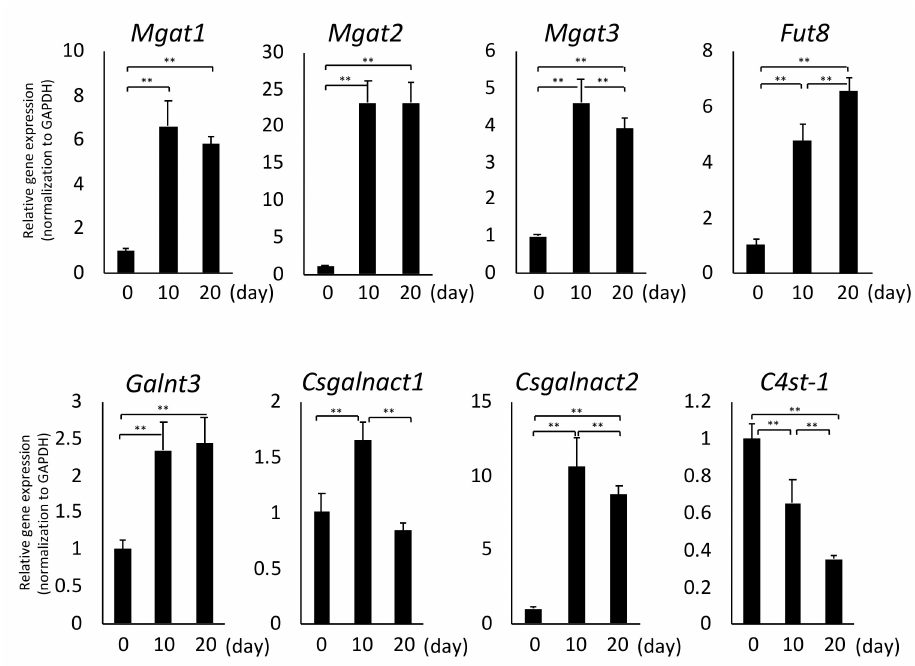
Figure 5. Gene expression levels of glycosyltransferases during hypertrophic di ff erentiation involved in glycan biosynthesis and processing. The mRNA expression levels on the indicated days as determined by quantitative RT-PCR. Data represent the relative gene expression in chondrocytes on each day compared with that in cells on day 0 (set to 1.0 separately for each target gene; n = 3 per group; * 0.01 < p < 0.05; ** p < 0.01). The results are expressed as the means ±